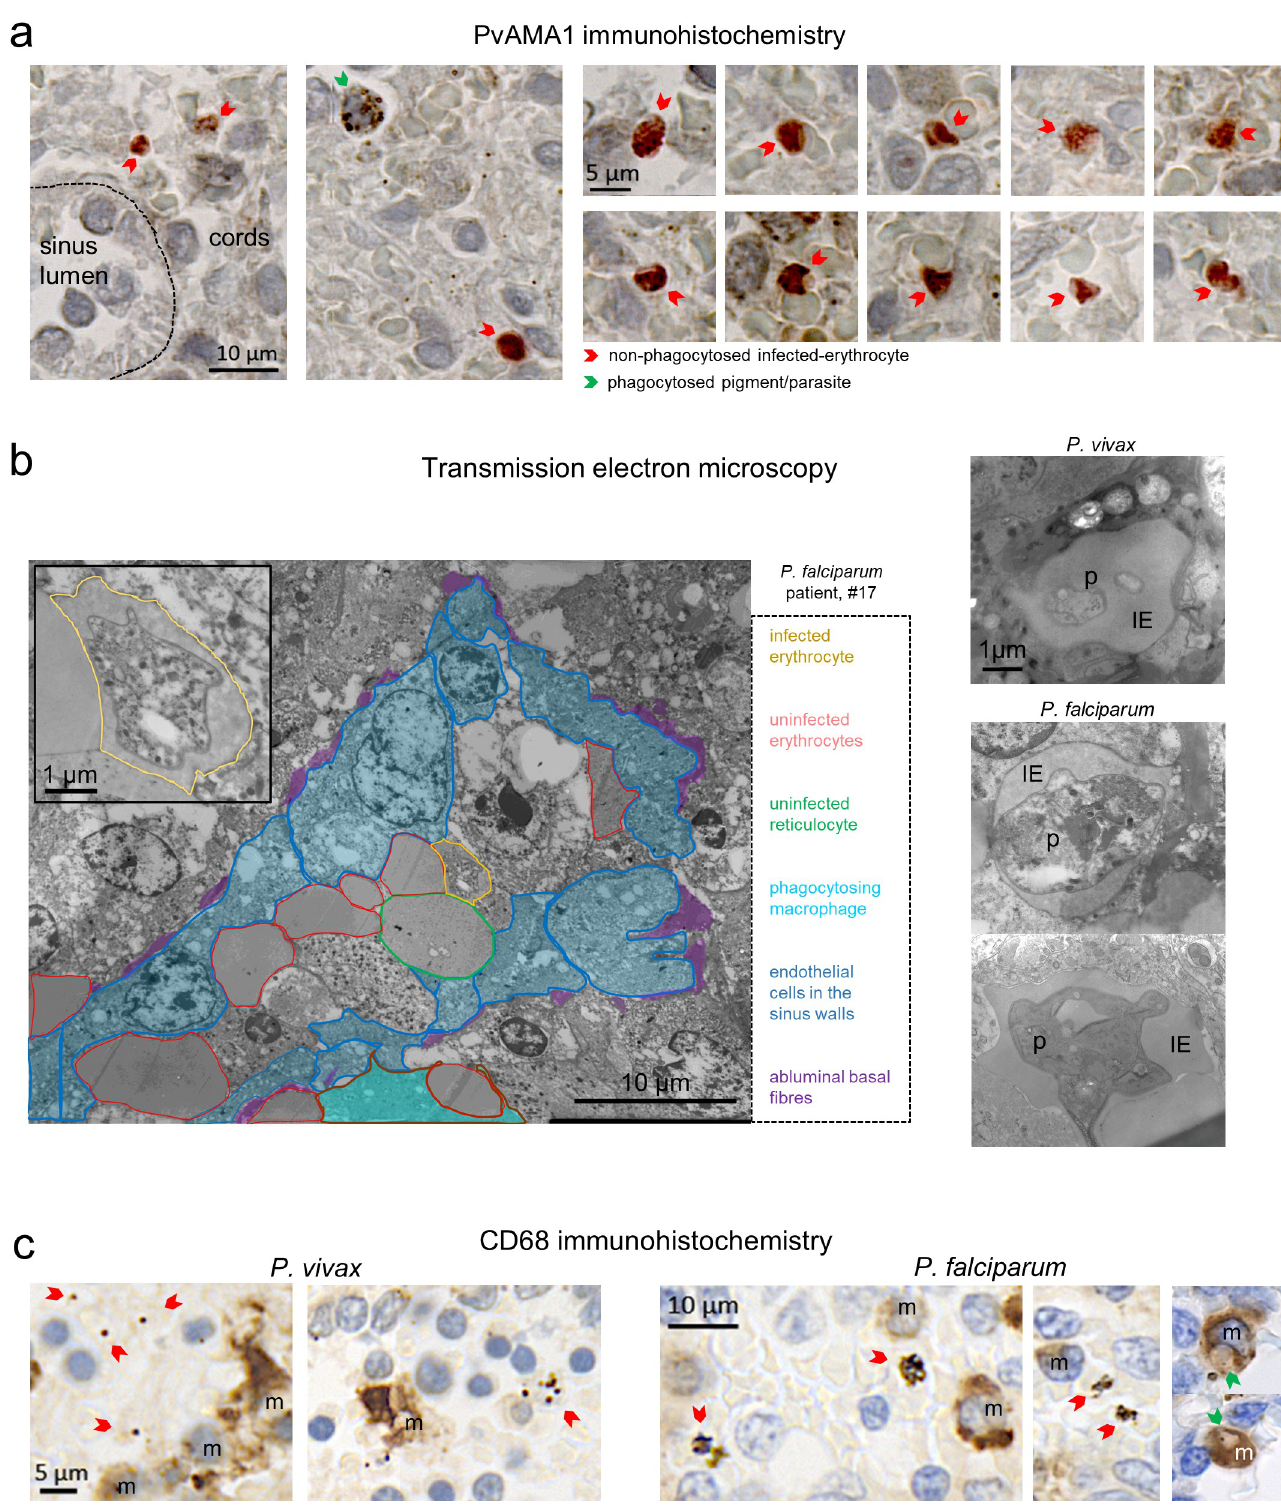
Fig 2. Confirming the integrity of non-phagocytosed IEs by immunohistochemistry and electron microscopy. Antibodies against PvAMA1, a marker for P . vivax merozoites/mature stages staining red, were tested on spleen sections from patient #1 (a) and others (S4D Fig) to confirm previous findings [29] on the presence of mature P . vivax stages. Spleen tissue from patients in the cohort was also examined by transmission electron microscopy to identify non-